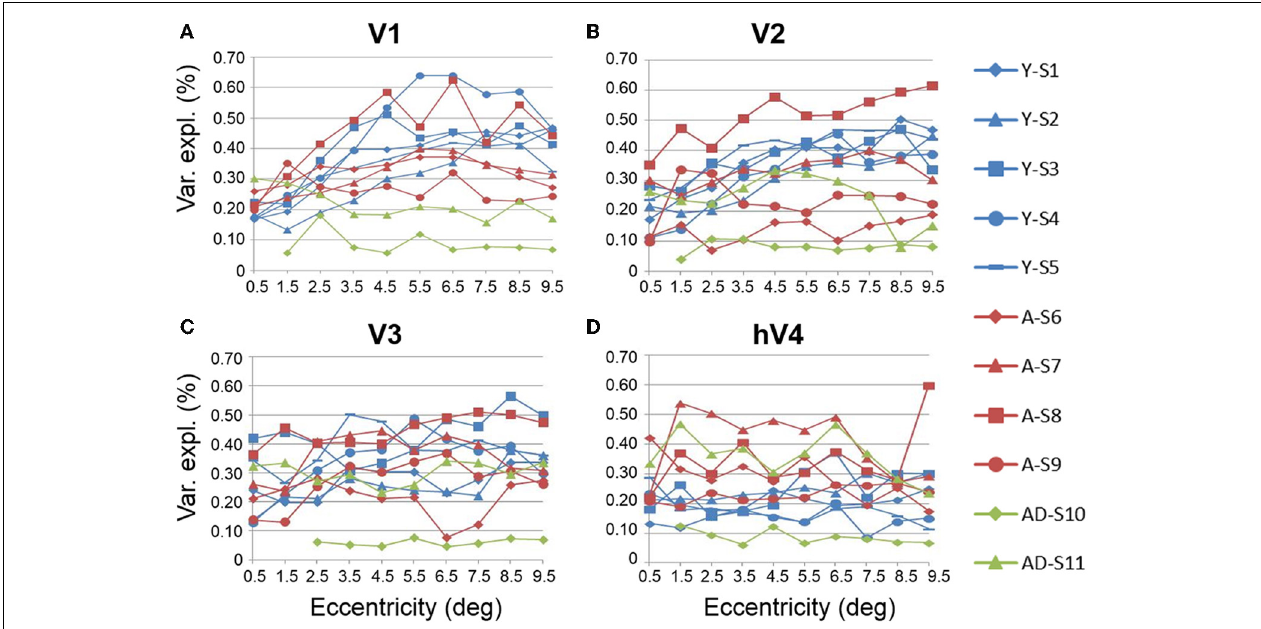
FIGURE 6 | Measurements of variance explained for visual field maps in individual young, healthy aging, and mild Alzheimer’s disease subjects. (A) V1. (B) V2. (C) V3. (D) hV4. Blue lines represent data from healthy young subjects, red lines represent data from healthy aging subjects, and green lines represent data from mild AD subjects. Each line represents data measured in individual subjects